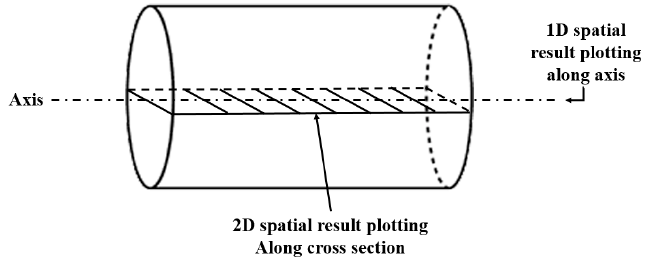
Figure 6. Numerical result reporting scheme.